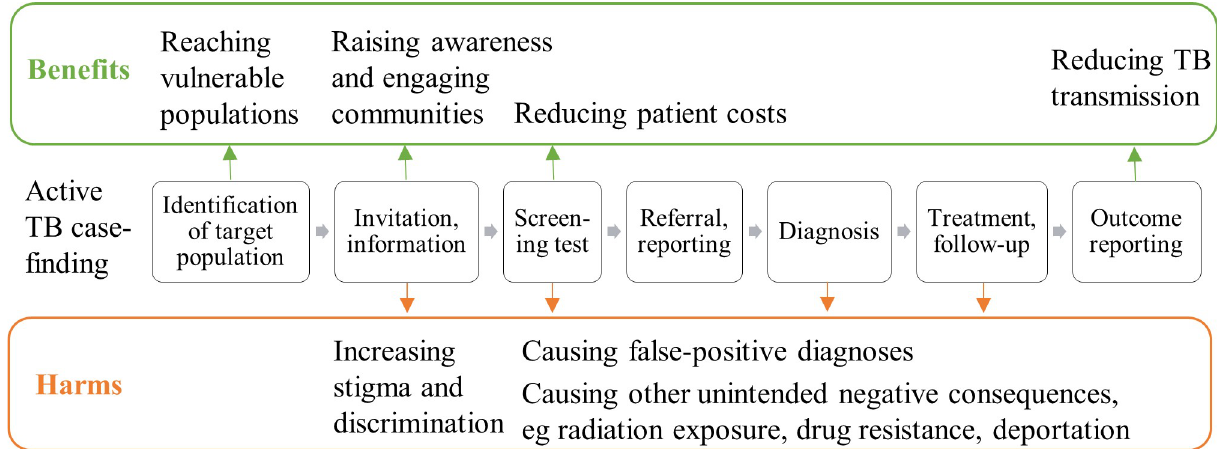
Fig 1. Considering benefits and harms of ACF throughout the screening pathway. This figure shows the seven-step screening pathway (adapted from WHO Europe [30]) for active tuberculosis case-finding from the identification of a target population to outcome reporting. The categories on the perceived benefits and harms of ACF are mapped along the